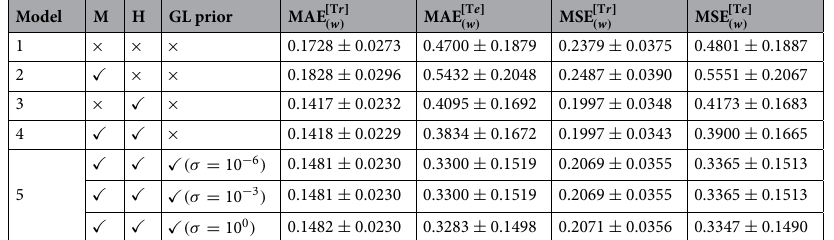
Table 4. Training and testing errors with standard deviation of Models 1–5 for simulated data with four provinces. The formulas of errors are detailed in Sect. B (Eq. (S5)) of Supplementary Information. Remarks for Columns 1–4 and the choice of µ = 10 2.7 in Model 5 are the same as those in Table 3. MAE [ T r ] [ T e ] MSE ( w ) and MSE ( w ) are computed for each of the 100 replicas, then the mean and standard deviation are presented in the table